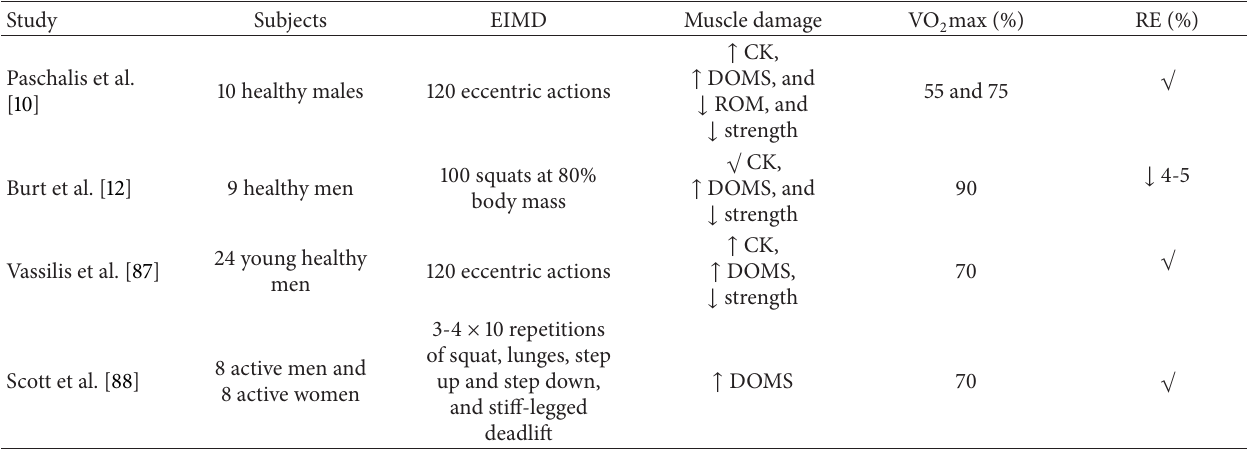
Table 1: Comparison of the effects of the resistance exercise on running